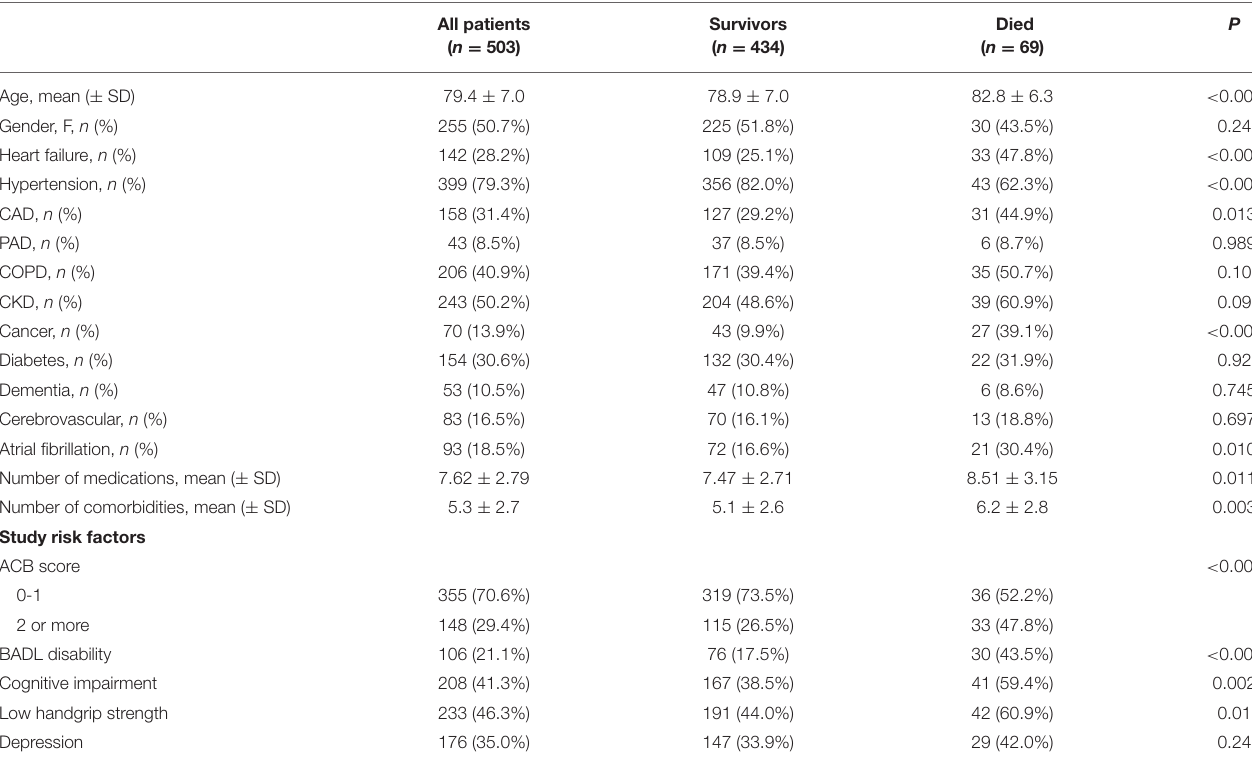
TABLE 1 | Demographic and clinical characteristics of discharged patients grouped by 1-year mortality.